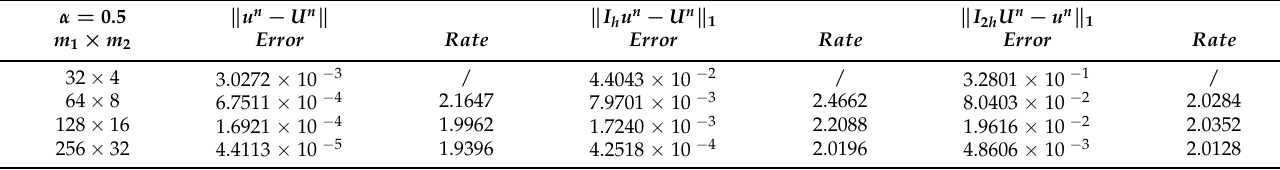
Table 5. Spatial numerical results of (cid:101) = 0.05 on anisotropic meshes to Example 1. α =